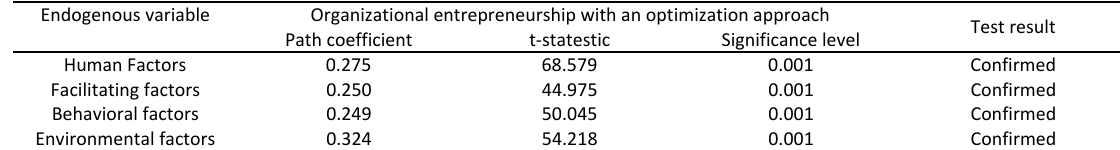
Table 5: T‐statistics and research impact Table 5: T-statistics and research impact coefficients